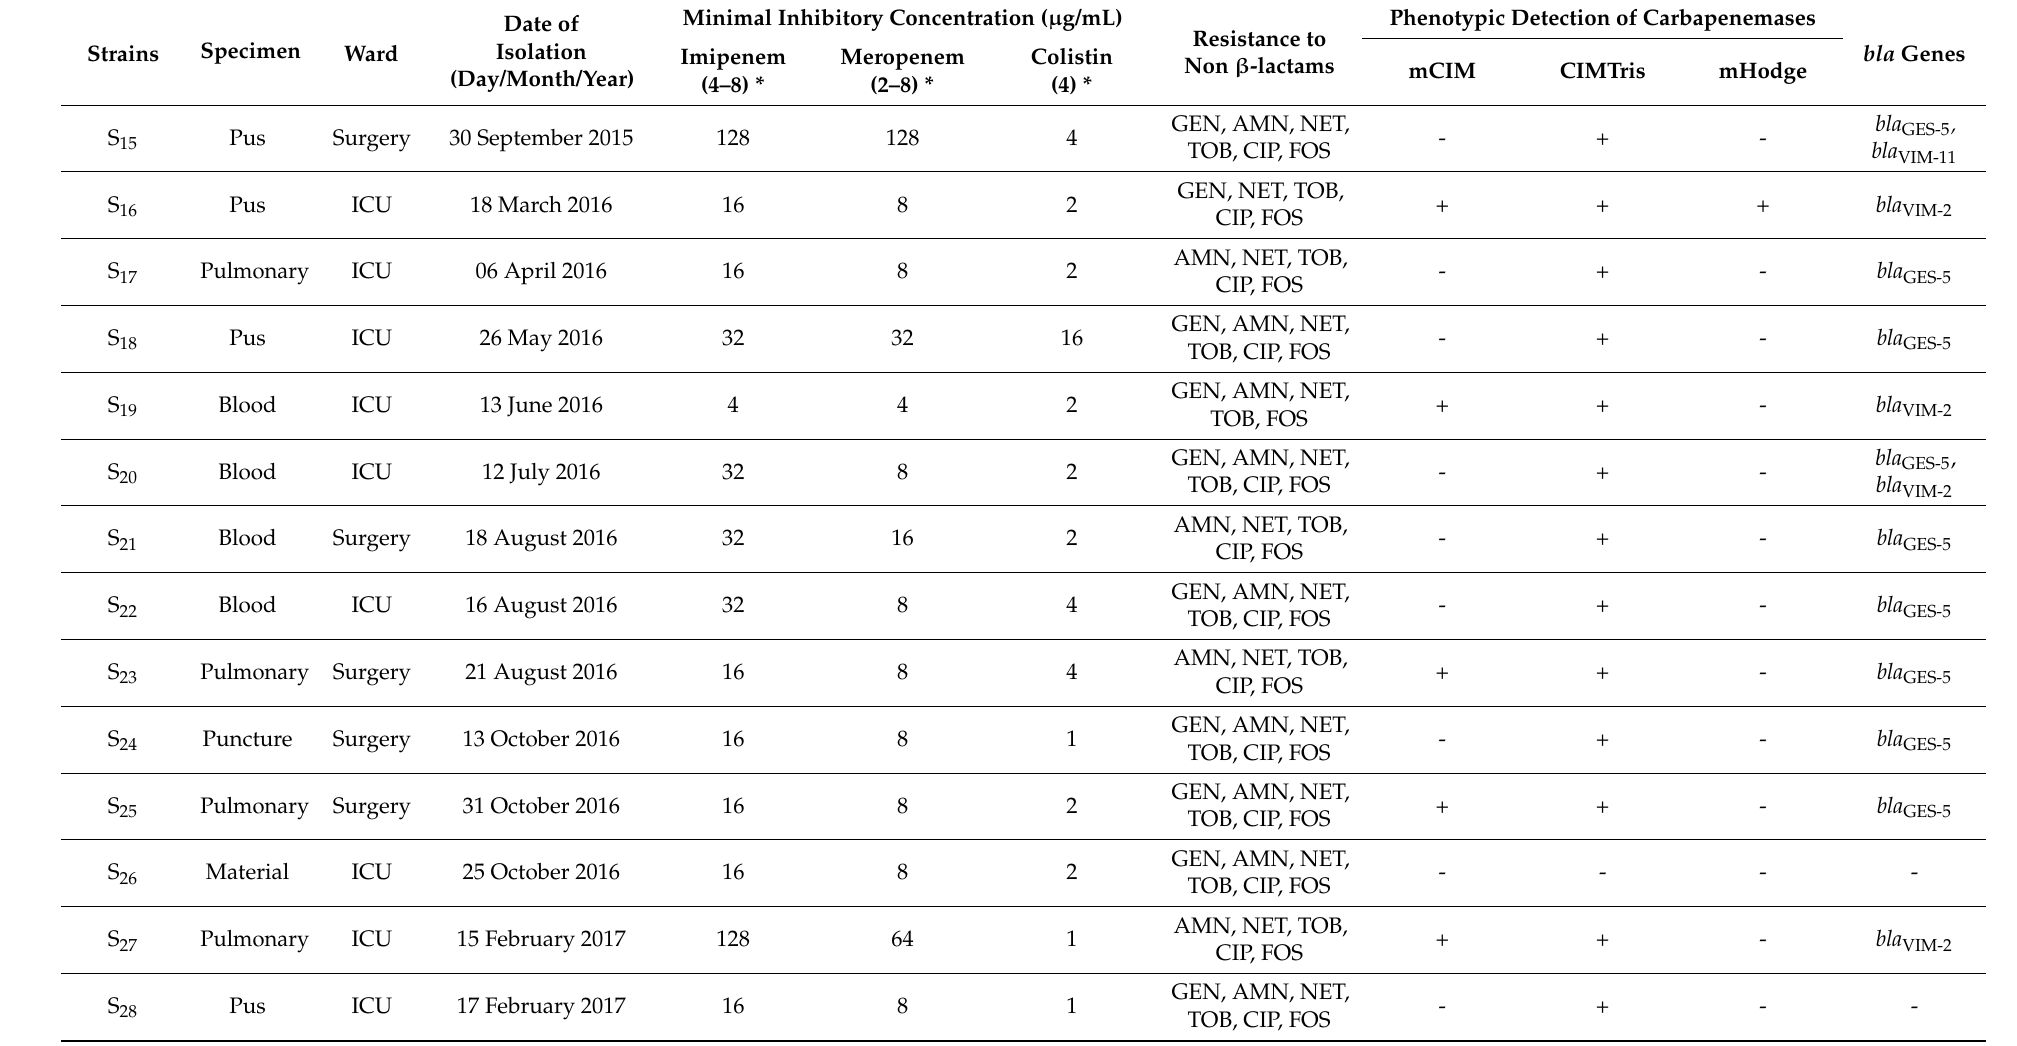
Table 3. Characteristics of imipenem- and ceftazidime-resistant P. aeruginosa isolates ( n =